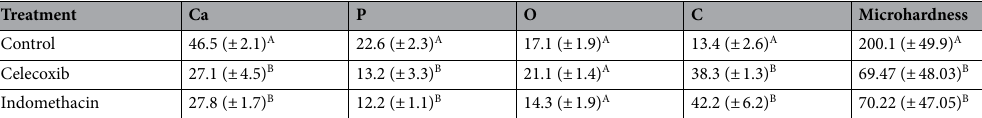
Table 1. Chemical elements content (%/w) and enamel Knoop microhardness (KHN) in lower incisors of mice treated or not with NSAIDs. Ca calcium, P phosphorous, O oxygen, C